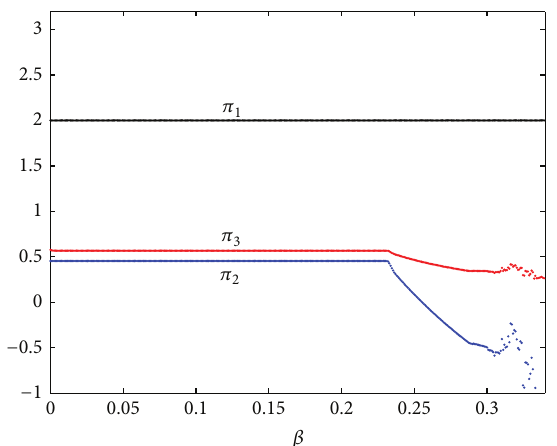
Figure 7: The long-run average profits of the players with 𝛽 for system (7).